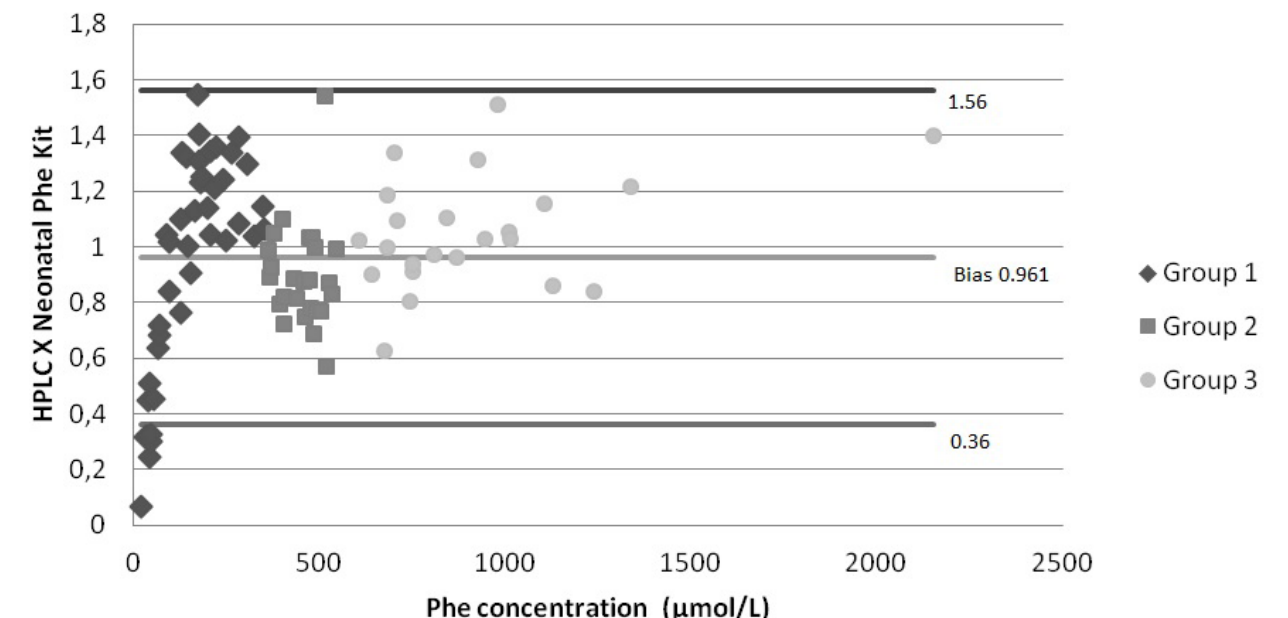
Figure 4. Ratio of phenylalanine (Phe) concentration in dried blood spots measured by the Neonatal Phe Kit (method B) and by high- performance liquid chromatography (HPLC) (n = 89 blood samples). Group 1: <360.0µmol/L; Group 2: >360.0 µmol/L and <600.0 µmol/L; Group 3: > 600.0